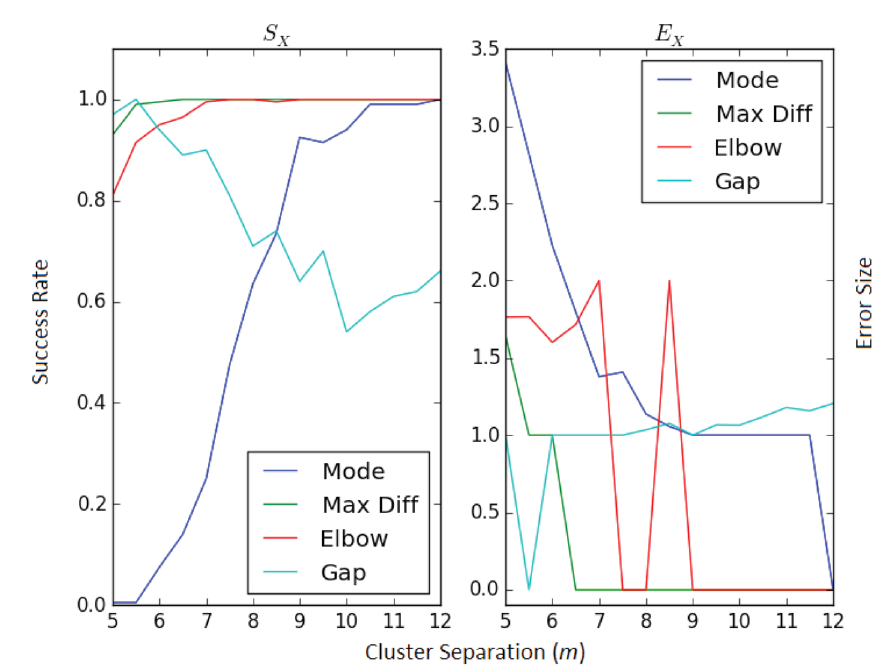
Figure 3. Tracking for varying distances.